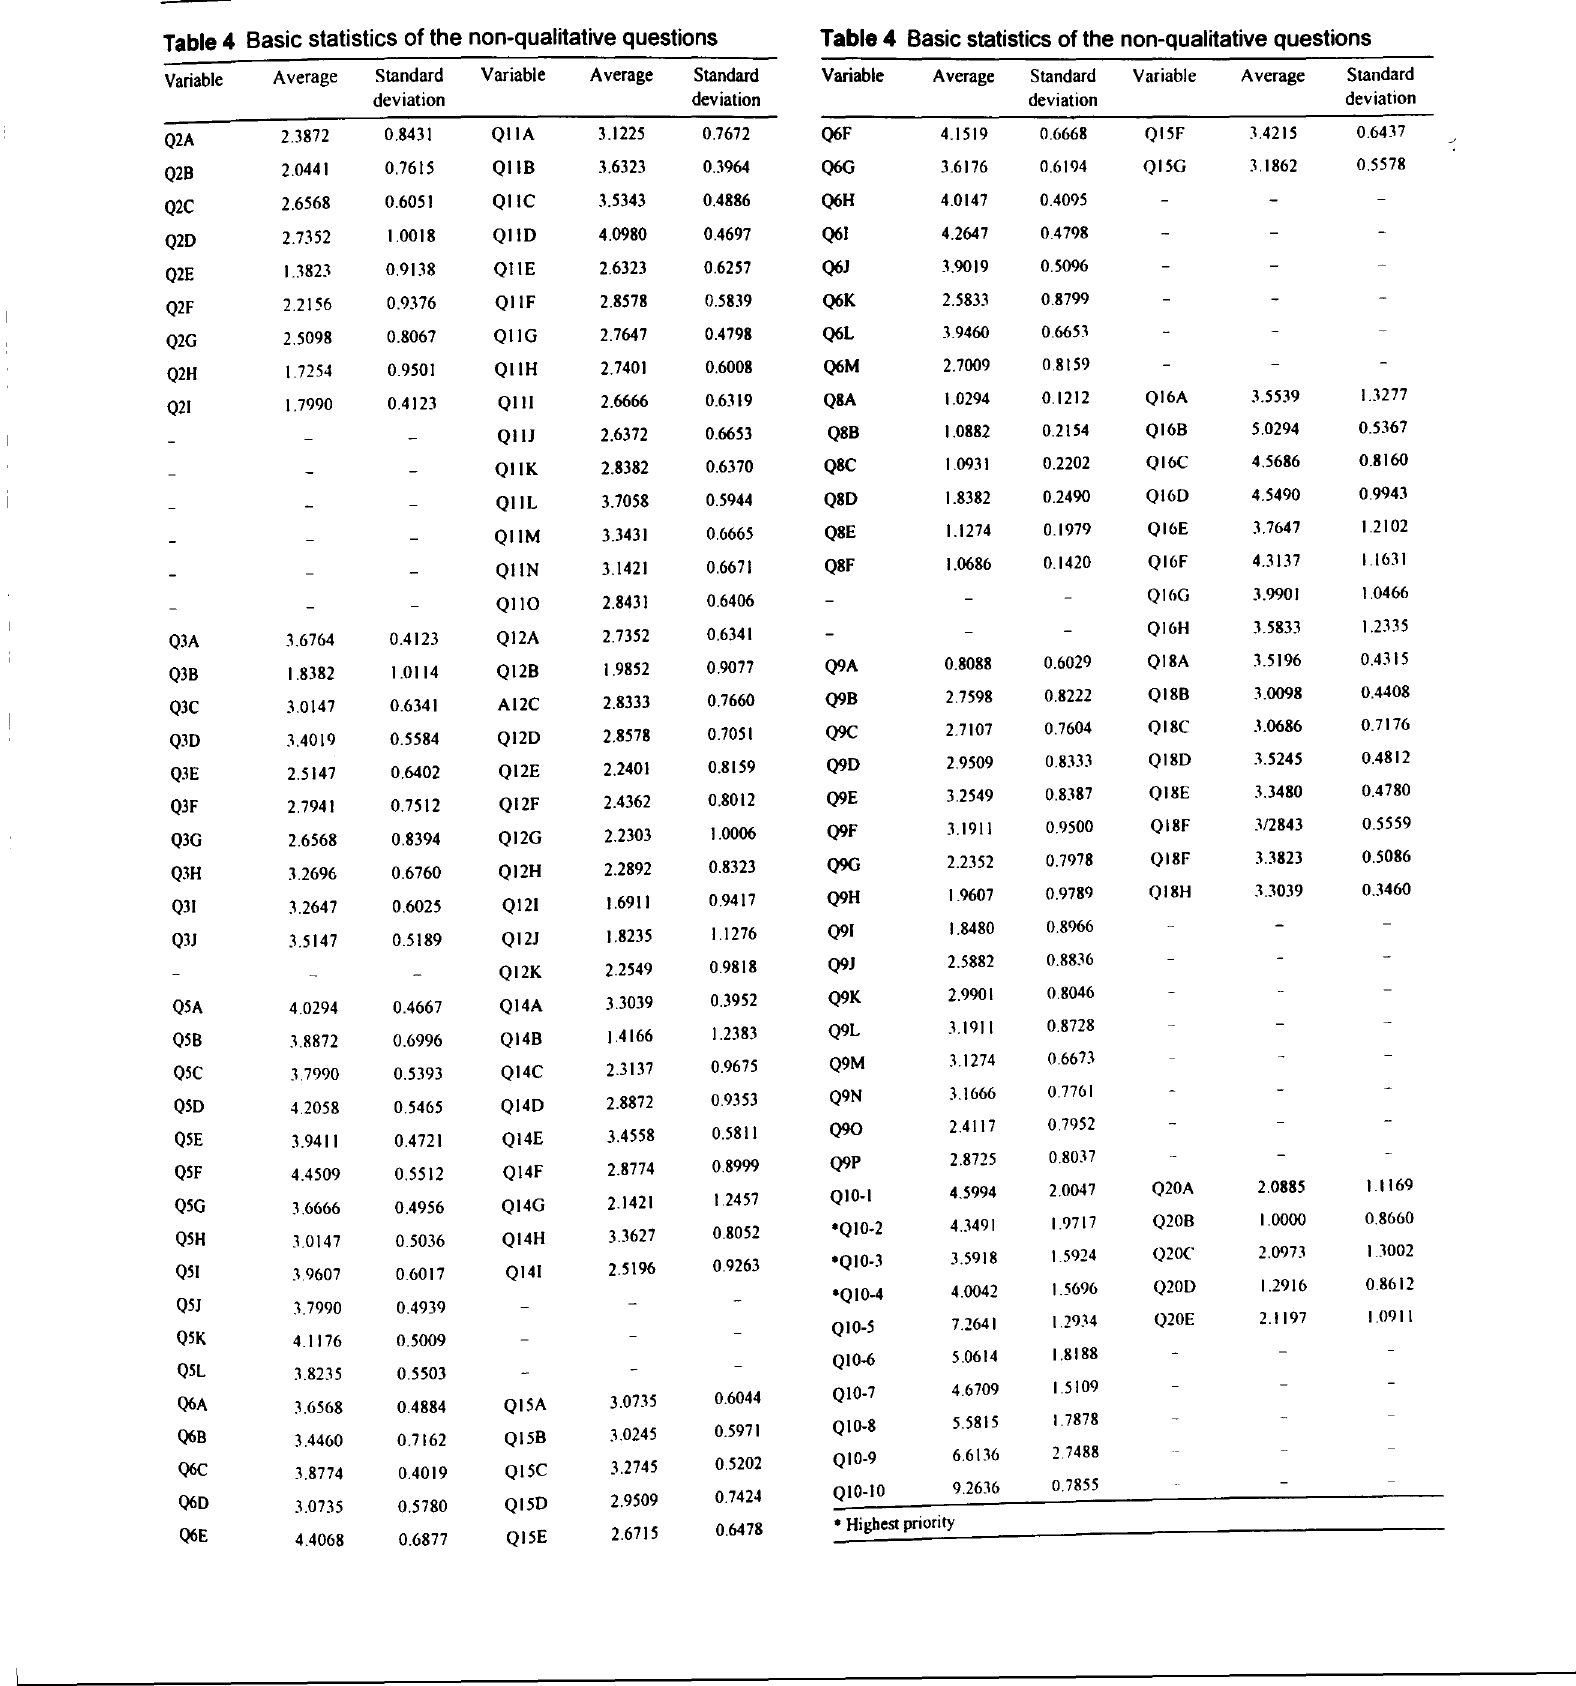
Table 3 Survey data of the analysis unit